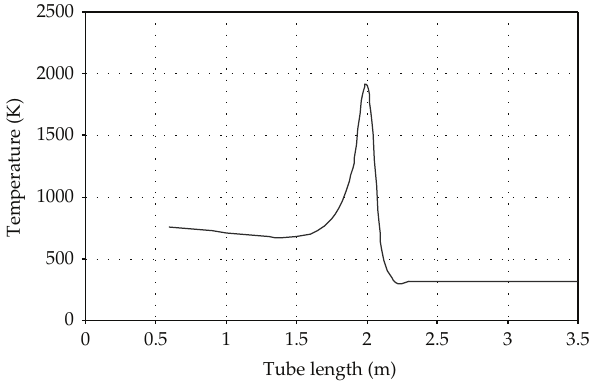
Figure 5: Temperature distribution along the tube length for case